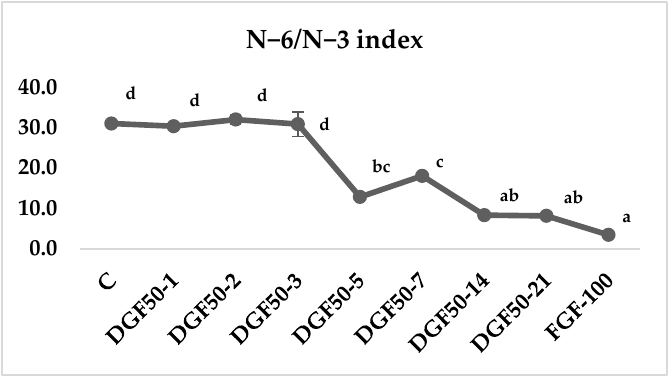
Figure 2. n − 6/ n − 3 ratio of Tenebrio molitor larvae fed with fish-based diets. The same letter is not significantly different from one another ( p < 0.05).